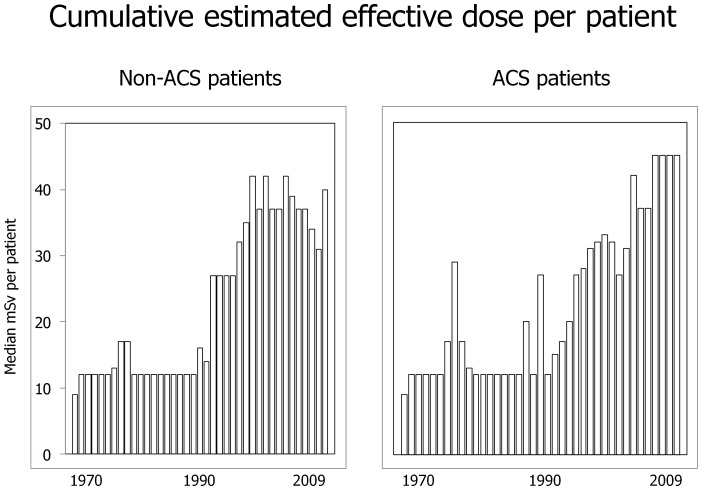
Secular trends of cardiovascular medical radiation exposure over the last 40 years in ischemic (IHD) patients.Radiation exposure is expressed as cumulative estimated effective dose/patient. On the left panel, trend of chronic angina patients (Non-ACS), and on the right trend of acute coronary syndrome (ACS) patients.